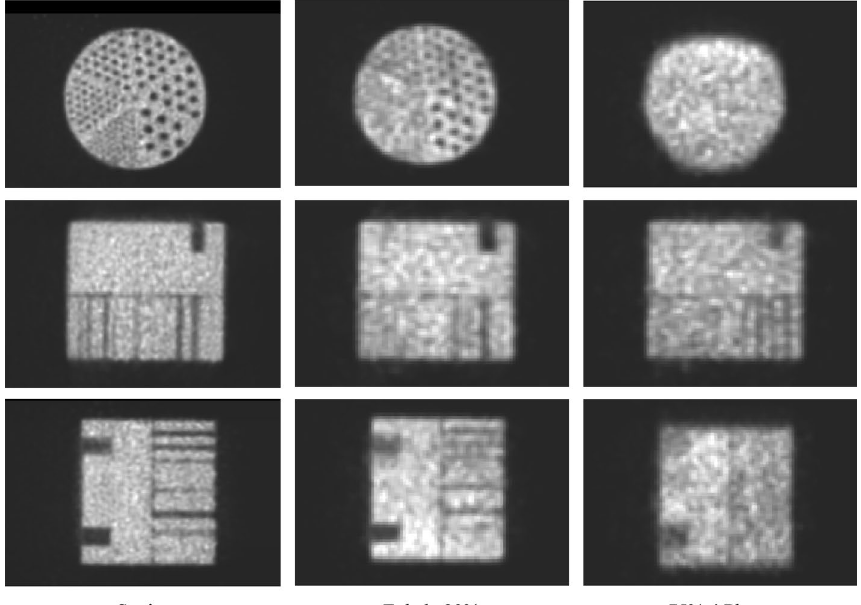
Fig. 14 Coronal, axial and sagittal PET images for reference static protocol, Exhale 30% protocol and 4 Phases protocol of the Jaszczak phantom